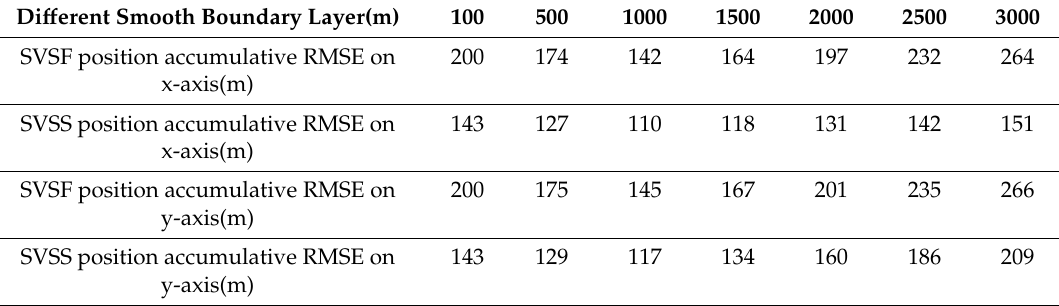
Figure 6. The position accumulative of different ψ on the x-axis and y-axis (m). Table 2. The position accumulative RMSE on the x-axis and y-axis (m) for different smooth boundary layer widths.